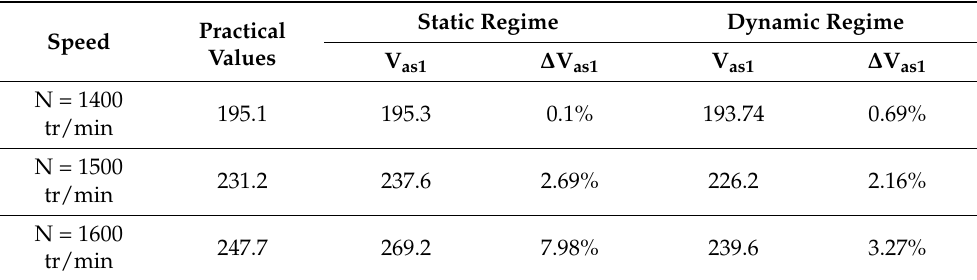
Table 2. Static and dynamic results at no load with C = 9 µ F and variable speed.